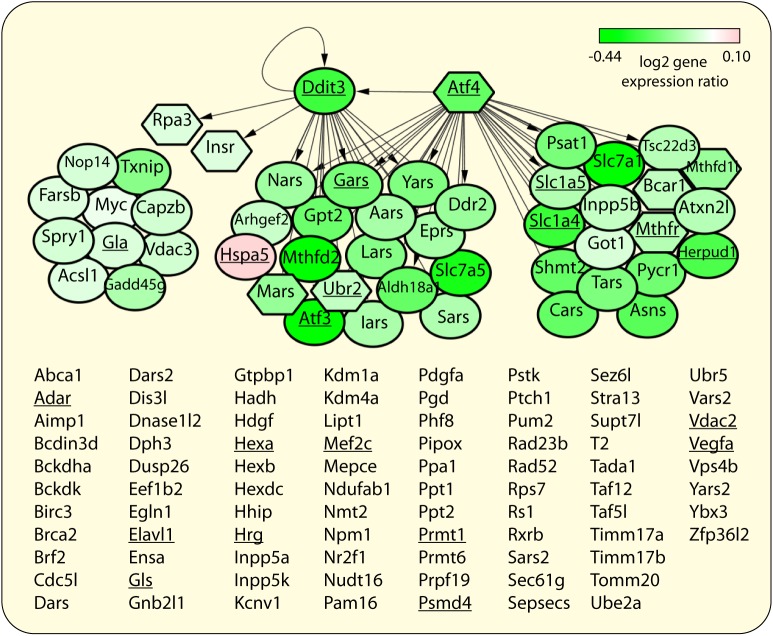
The 134 genes from the ALS gene expression classifier.Genes that are either transcriptionally responsive to ER stress [32] or directly targeted by TFs ATF4 (Atf4) and CHOP (Ddit3) during ER stress [32] are shown as nodes (depicted using Cytoscape [33]). Node color indicates mean log2 differential expression level in the indicator cell assay (disease versus normal) ranging from –0.44 (green) to 0.1 (pink). Node shape indicates genes that are transcriptionally responsive to ER stress (oval) or are not (hexagon) [32]. 133 of the 134 genes are known to have human orthologs and underlined genes co-occur with “amyotrophic lateral sclerosis” in titles or abstracts of articles in PubMed (on 01/15/15).